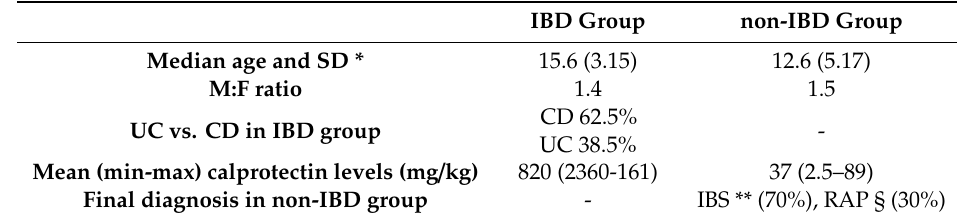
Table 1. Demographic, clinical and baseline features of inflammatory bowel (IBD) and non-IBD